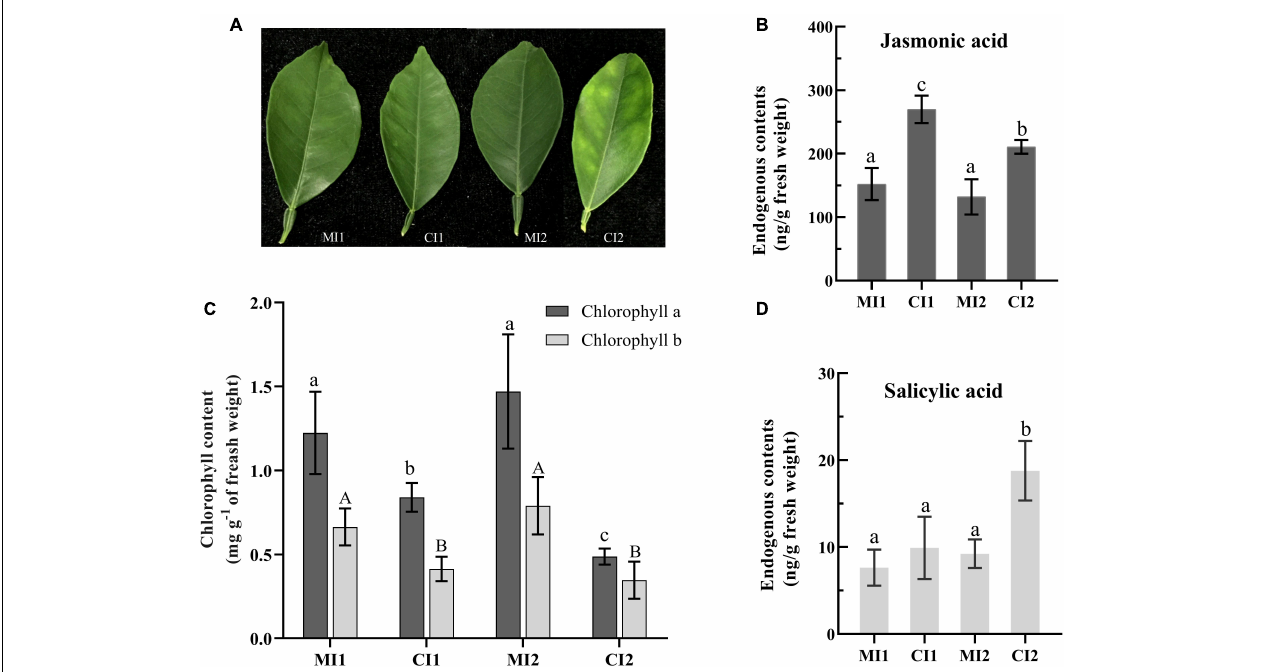
FIGURE 1 | (A) The leave types used in the experiment. The level of jasmonic acid (B) and salicylic acid (D) in leaf petioles. (C) Content of chlorophyll in citrus leaf tissues. Representative leaves and their chlorophyll and phytohormone contents of MI1, CI1, MI2, and CI2. Different letters indicate significant differences at P < 0.05, determined using one-way ANOVA with Tukey’s post hoc test. Error bars represent the SD. MI1 and MI2 represent the sample collected from mock-inoculated citrus trees at 16 and 22 weeks after grafting, respectively. CI1 and CI2 represent asymptomatic sample collected at 16 weeks after grafting and symptomatic sample collected at 22 weeks after grafting from Ca. L. asiaticus-inoculated citrus trees, respectively.